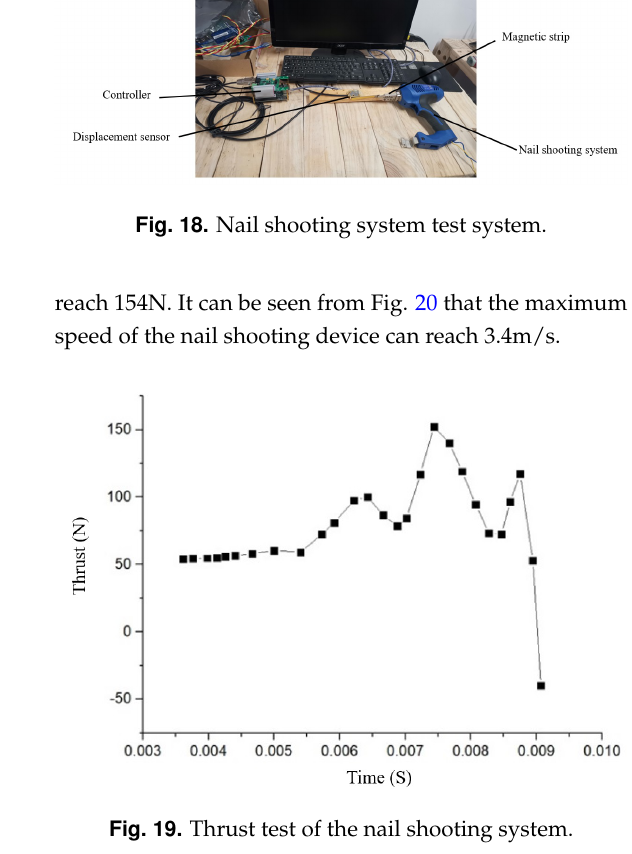
Fig. 19. Thrust test of the nail shooting